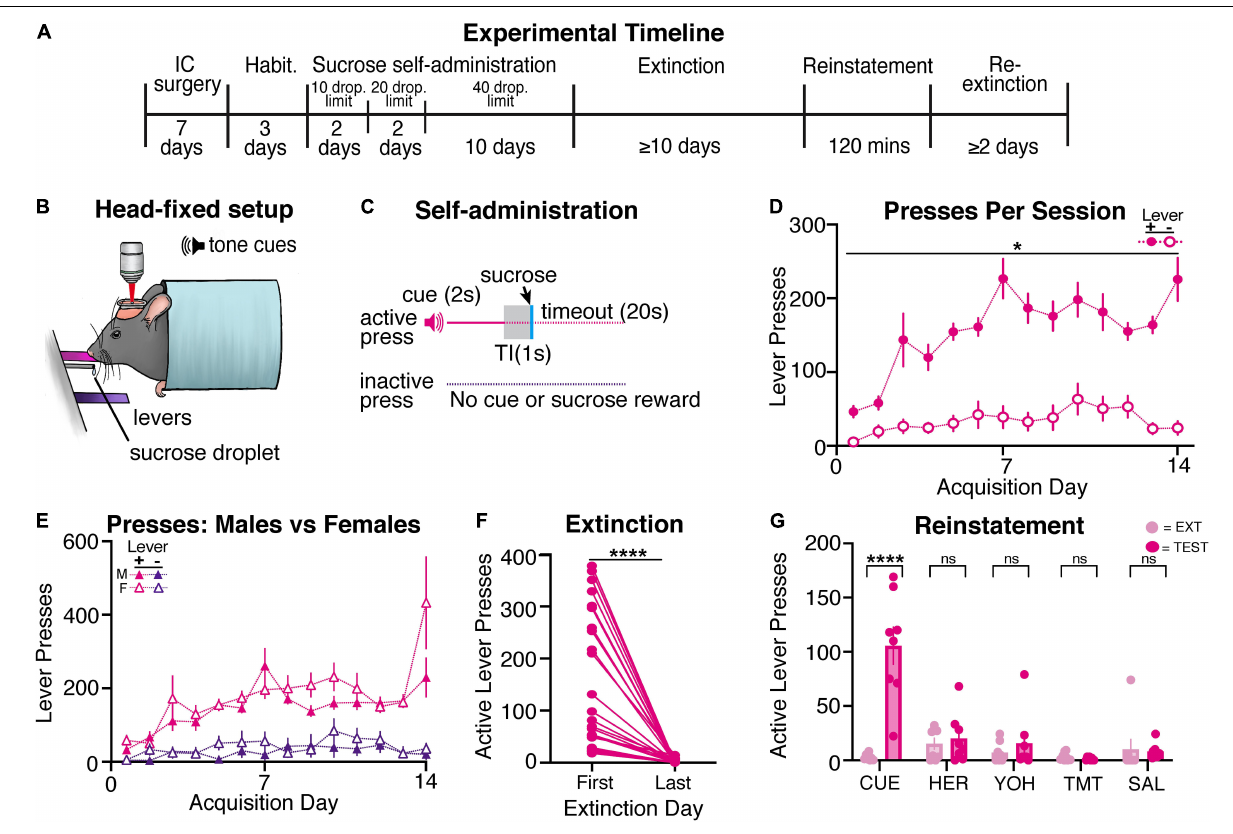
FIGURE 3 | Head-restrained mice self-administer sucrose and display reinstatement of sucrose seeking to the reward-associated cue. (A) An experimental timeline demonstrating the behavioral procedure used for head-restrained sucrose self-administration. (B) Illustration of head fixation for sucrose self-administration experiments. Active lever presses resulted in a tone cue that predicted a sucrose droplet (12.5 µ l of 12.5% sucrose). (C) Schematic for sucrose self-administration experiments, where active but not inactive lever presses resulted in a tone cue (2s), a gap in time (TI, trace interval; 1s), a palatable sucrose droplet, and a timeout period (20s). (D) Sucrose self-administering mice pressed the active lever significantly more than the inactive lever on each day of acquisition (* ps < 0.05). (E) A comparison of active and inactive lever pressing across sexes. Male and female sucrose self-administering mice showed no differences in lever pressing across acquisition. (F) All sucrose self-administering mice significantly decreased active lever pressing from the first day of extinction to the last (**** p < 0.001). (G) Sucrose self-administering mice displayed an increase in active lever pressing to cue- (**** p < 0.001), but not heroin-, yohimbine-, predator odor (TMT)-, or saline-induced reinstatement